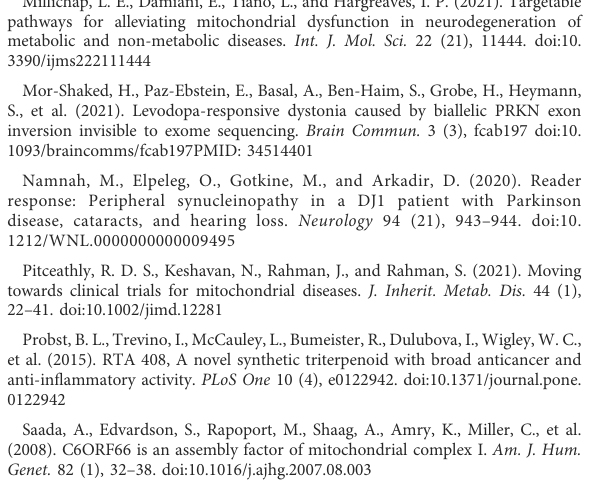
Effect of omaveloxolone on cell growth using two different methodologies. An equal amount of control cells (CONT) cells with mitochondrial CI (C1) or COX (COX) de fi ciency or PD with mutated PRKN (PD-P) or mutated DJ-1 (PD-D) was seeded in parallel microtiter wells, cultivated in the presence or absence of 50 nM omaveloxolone (OMA) for 72 h in GLU medium. Subsequently, relative cell growth was measuredby (A) methyleneblue(MB)andby (B) viablecellcountingusing aMUSEcellanalyzer.Theresultsarepresentedasmean±SD,compared to the individual cell without additive * <